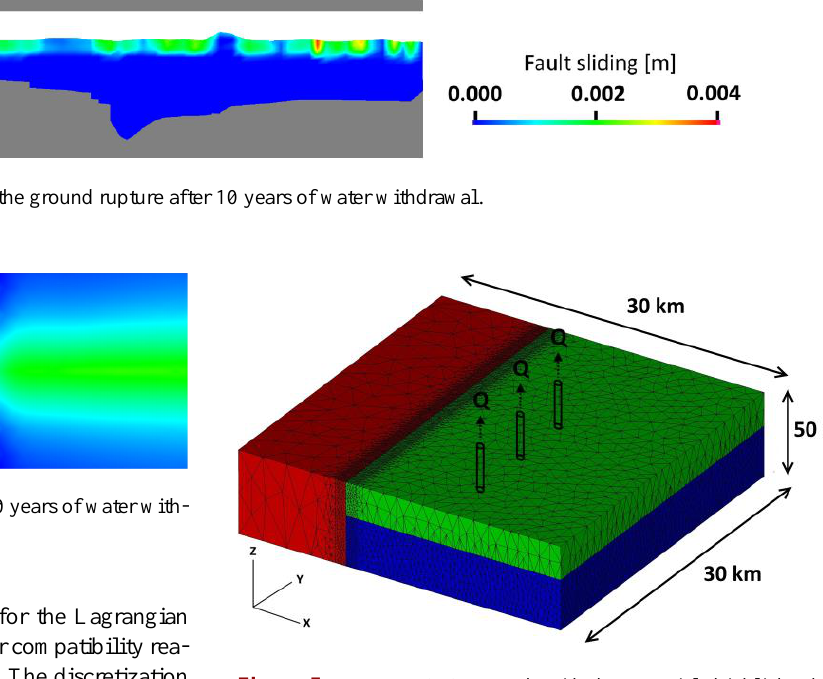
Figure 5. Test case 2: 3-D mesh with the materials highlighted in various colours. Rock is red, aquifer is blue, and clay is green. The fault divides rock from the sedimentary clay-aquifer